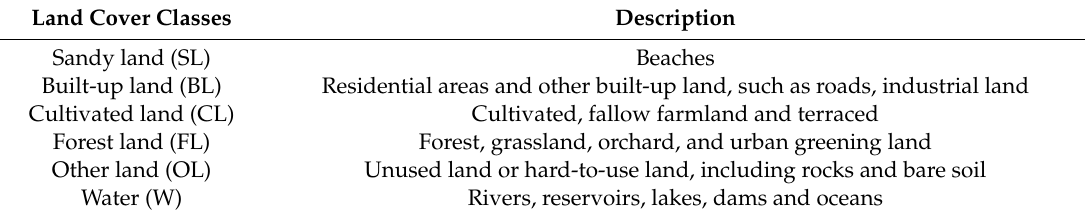
Table 2. The description of land cover classes on Haitan Island,